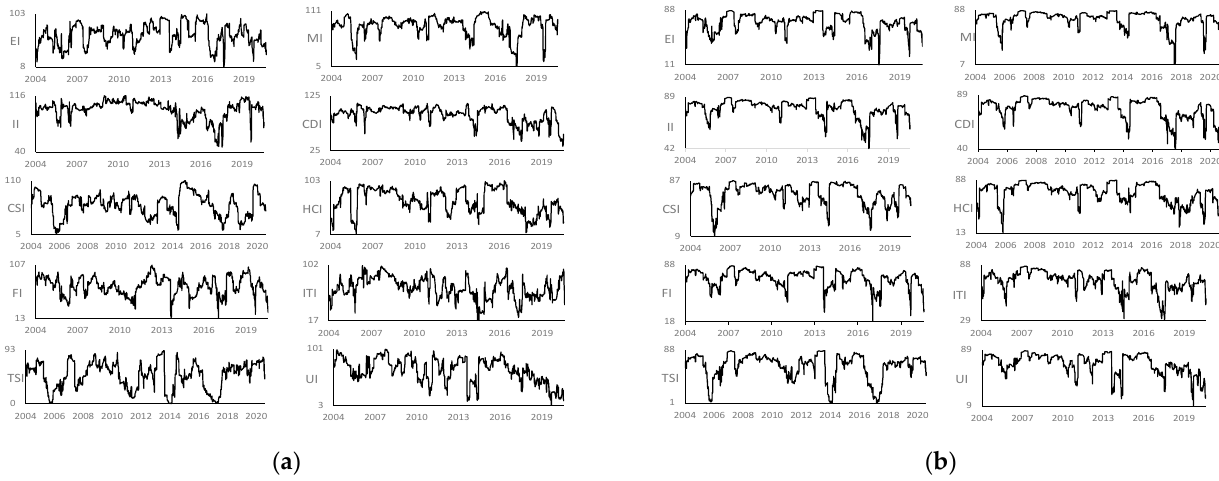
Figure 2. Directed volatility spillover index for 10 sectors in China’s stock market (2004–2020). ( a ) shows the dynamic of “From” spillover index and ( b ) shows the dynamic of “To”spillover index.